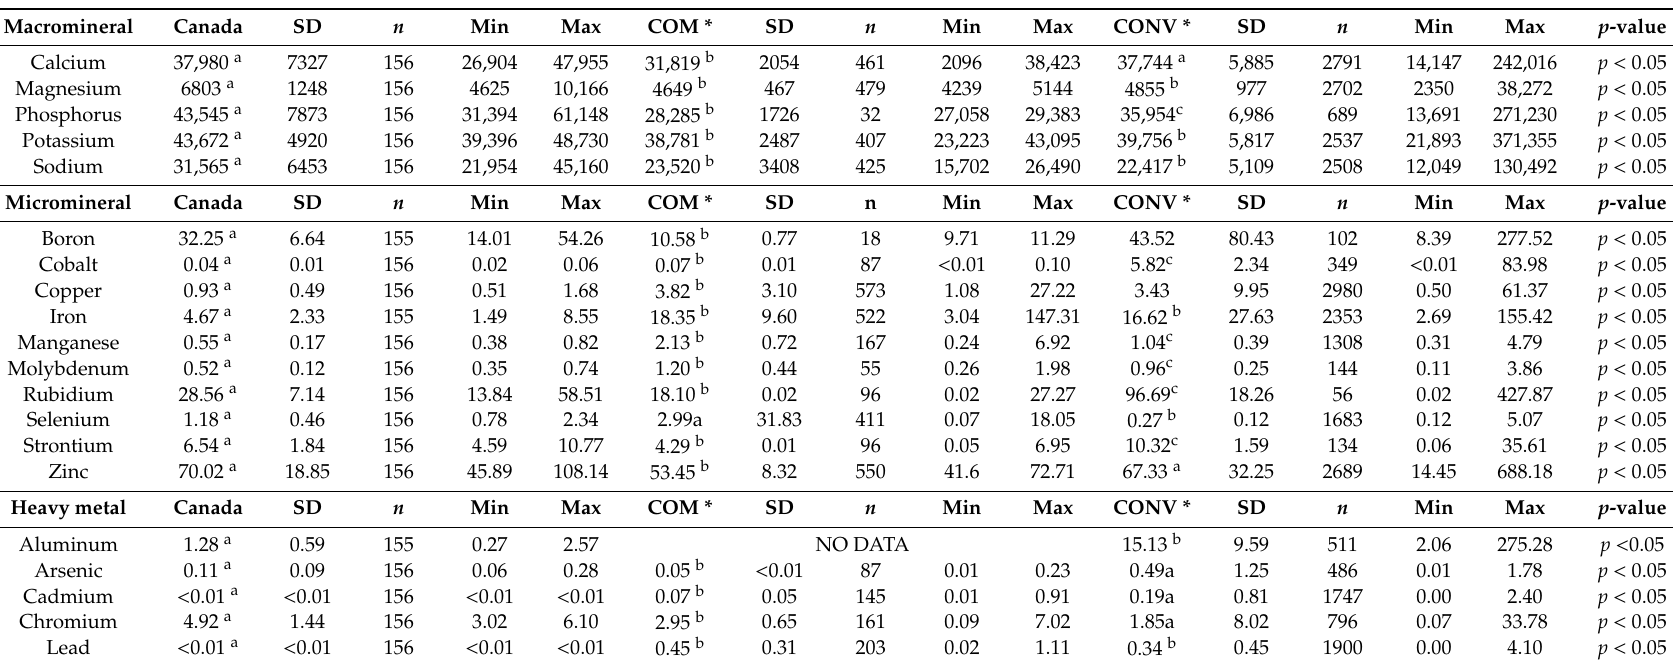
Table 3. Concentration of macro- and microminerals as well as heavy metals in the raw milk of dairy cows in Alberta, Canada compared with the retail store milk (commercial) and farm milk (conventional) around the